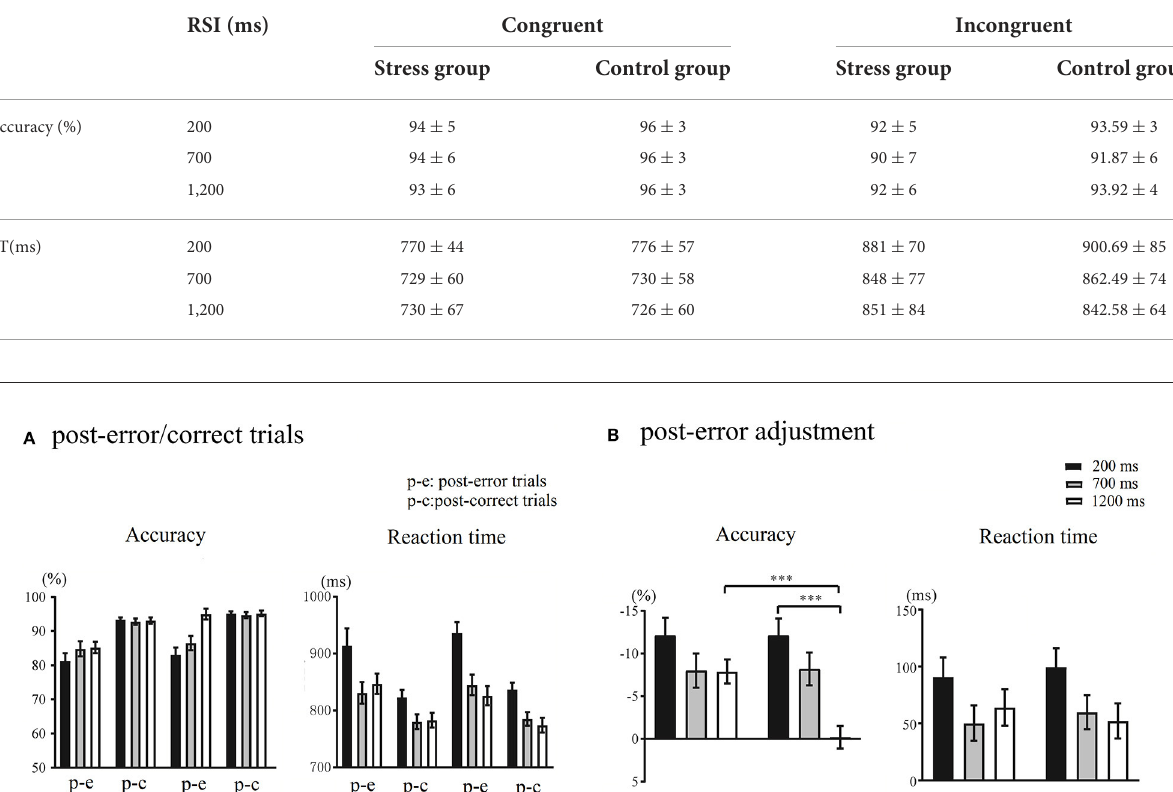
TABLE 2 Accuracy and response times (RTs) of congruent and incongruent trials during different response stimulus intervals (RSIs) (M ± SD).